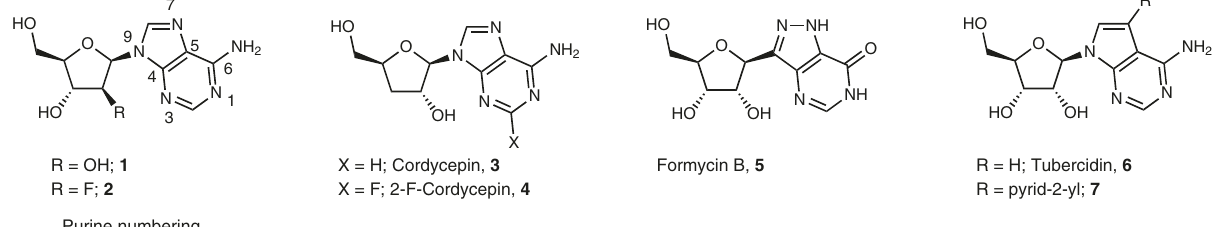
Fig. 1 Different nucleoside analogues with reported activity against African trypanosomes. [Cordycepin: TCMDC-143080; Formycin B: TCMDC-143083 (codes originating from ref. 16